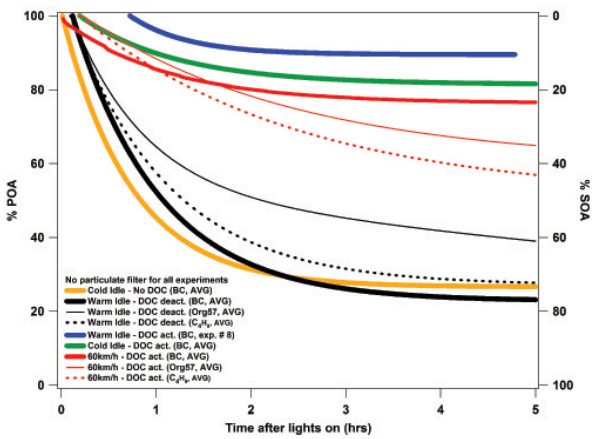
Fig. 5. Average POA and SOA contribution to total organic mass estimated using the black carbon assumption for wall loss correction (Eq. 2, thick solid lines), the C 4 H 9 normalization method (Eq. 5, thin solid lines) and the Org57 normalization method (Eq. 4, dashed